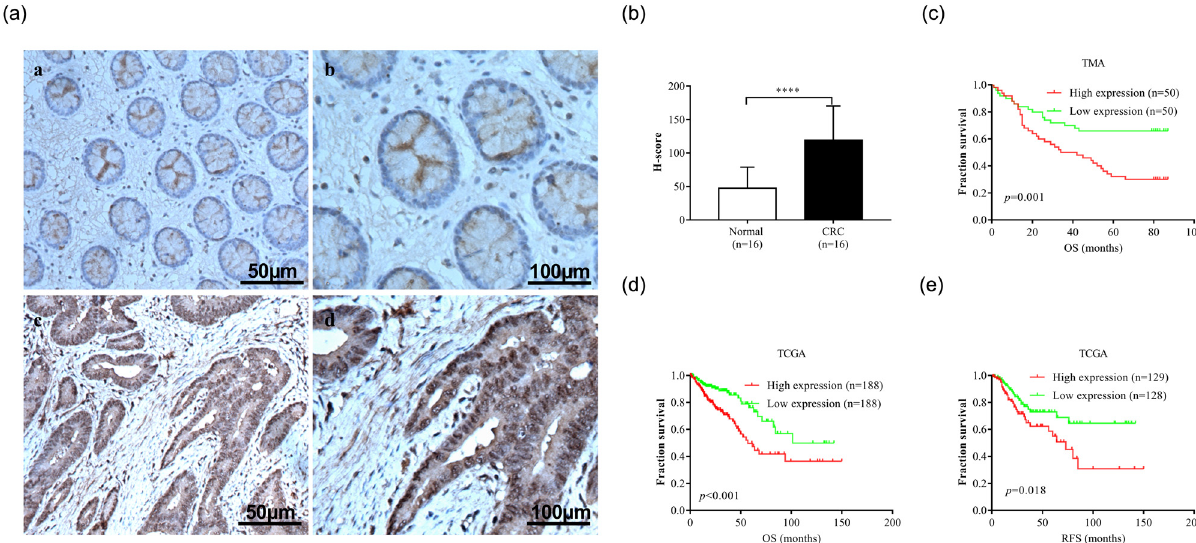
Figure 2: Overexpression of GABRD was associated with poor patient prognosis. The protein expression and localization of GABRD were characterized by IHC in 16 paired NTs and CRCs. GABRD expression was weak or negative in NTs and mainly localized to the cytoplasm and membrane ( a, a and b ) . By contrast, GABRD expression was stronger and localized to the nuclei, cytoplasm, and membrane in CRCs ( a, c and d; b ) . The prognostic value of GABRD in CRCs was explored with a TMA and validated using the combined TCGA - COAD and READ dataset. Kaplan – Meier plots demonstrated that the overexpression of GABRD was associated with unfavorable patient OS in the TMA cohort ( c ) and TCGA cohort ( d ) , and unfavorable patient RFS in the TCGA cohort ( e ) . P values were obtained by using the log - rank test. Censored data are indicated by the + symbol. Patients were strati fi ed into GABRD low and high expression according to the median H score or GABRD mRNA expression (< median vs ≥ median ) . Abbreviations: CRC, colorectal cancer; GABRD, gamma - aminobutyric acid type A receptor subunit delta; IHC, immunohistochemistry; NT, normal tissue; OS, overall survival; RFS, recurrence - free survival; TCGA - COAD and READ, the cancer genome atlas colon adenocarcinoma and rectal adenocarcinoma; TMA, tissue microarray. **** p <